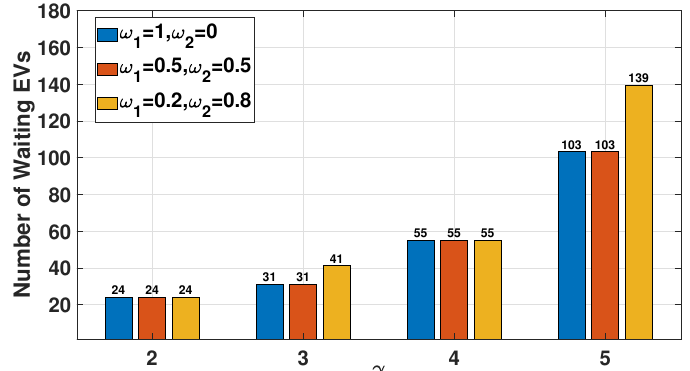
Figure 11. Comparison of the total number of waiting EVs at three FCSs in terms of different weights and normalized traveling times.